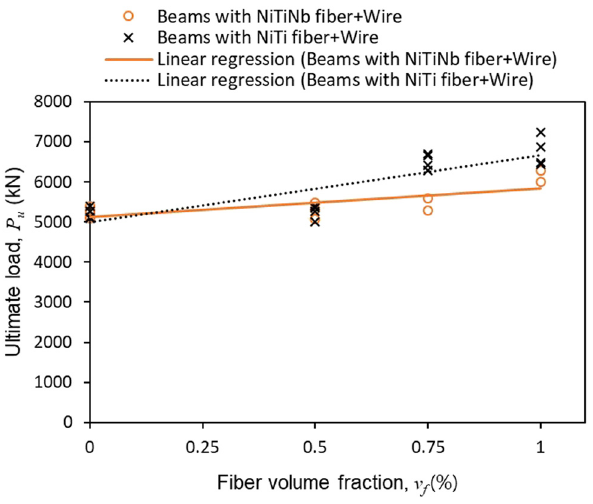
Figure 6: Ultimate loads of the beam specimens with fi ber volume